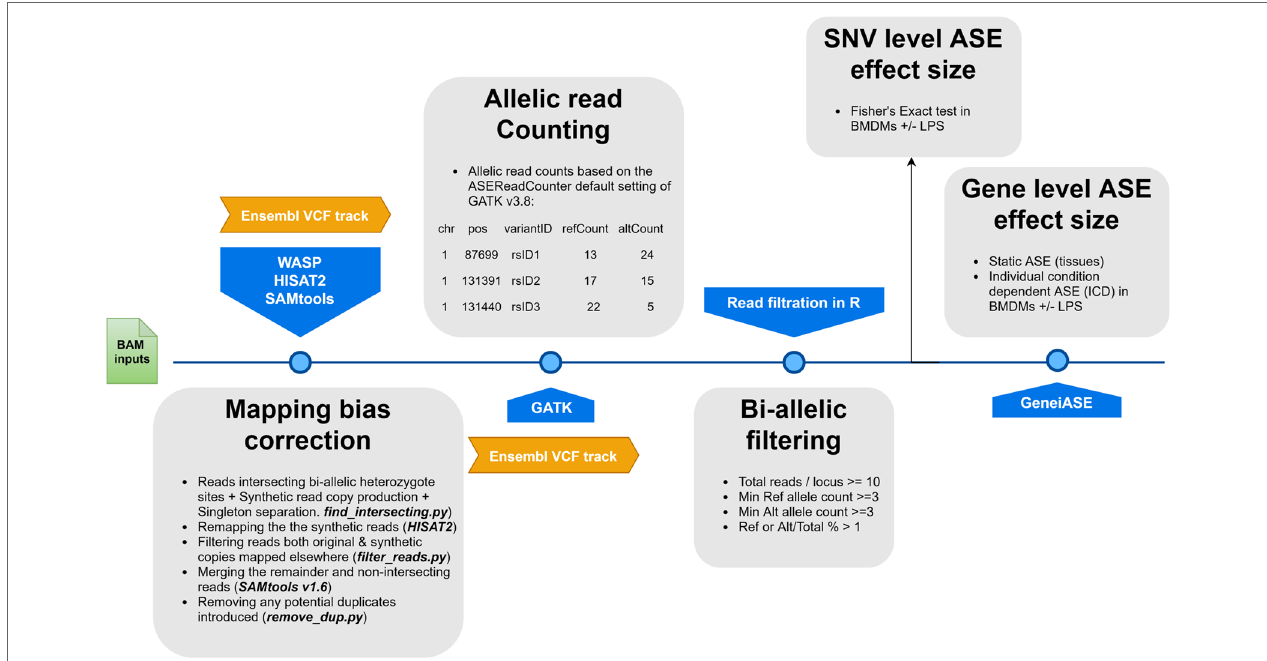
FIGURE 1 | A flowchart of the allele-specific expression analysis pipeline applied to the sheep gene expression atlas data set and optimized for WASP and GeneiASE programs. The remapping was carried out using HISAT2 (Kim et al., 2015) in combination with SAMtools (Li et al., 2009). The Genome Analysis Toolkit v 3.8 was used for the ASE read counting